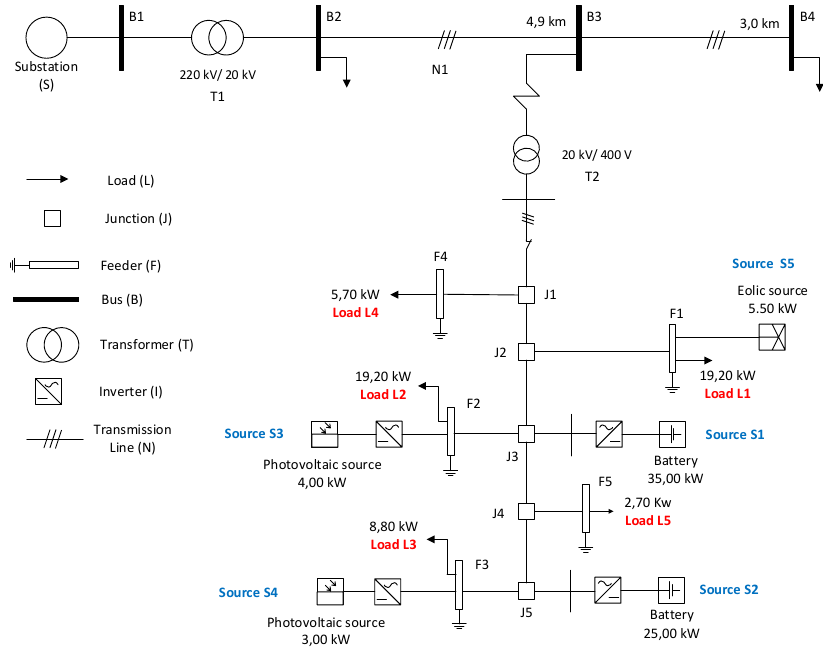
Figure 7. Evaluation scenario of a typical single-line